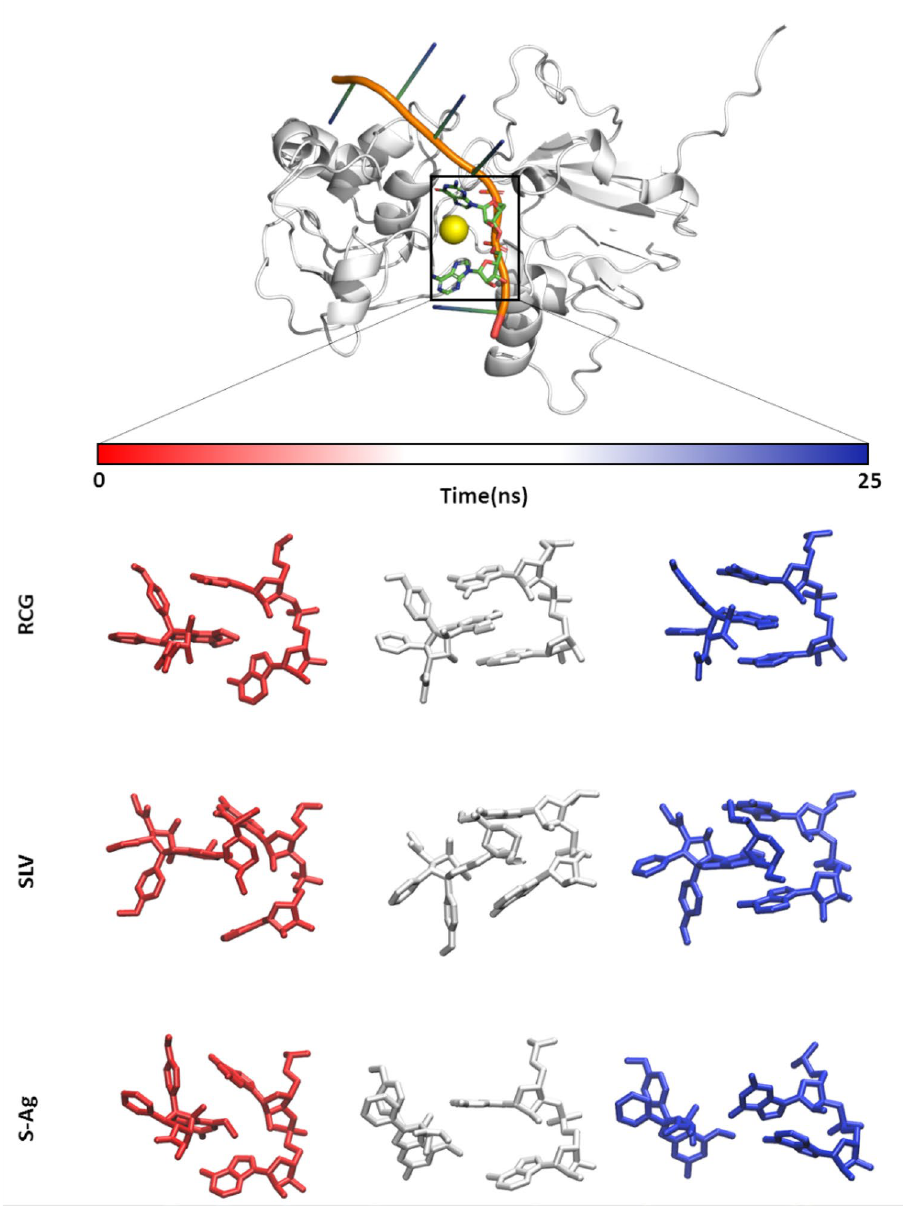
Figure 2. Protein-RNA-ligand complex and evolution over time of RCG, SLV and S–Ag with respect to the RNA bases. The protein is represented as a white cartoon, the RNA as an orange/green/blue cartoon while the two bases involved in the interaction with the ligand as green sticks. The yellow sphere represents the ligand docking-site. Under the time bar, starting from the top and moving to the bottom we can alternatively see the time-step sticks representation of both the RNA bases and RCG, SLV and S–Ag